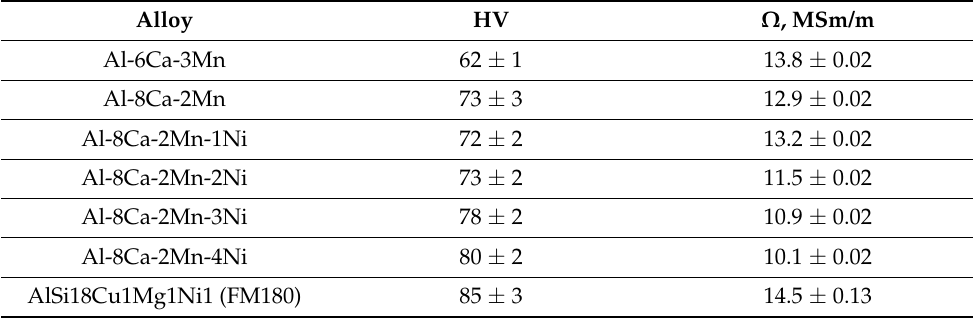
Table 5. Hardness and electrical conductivity of the alloys in the annealed condition.